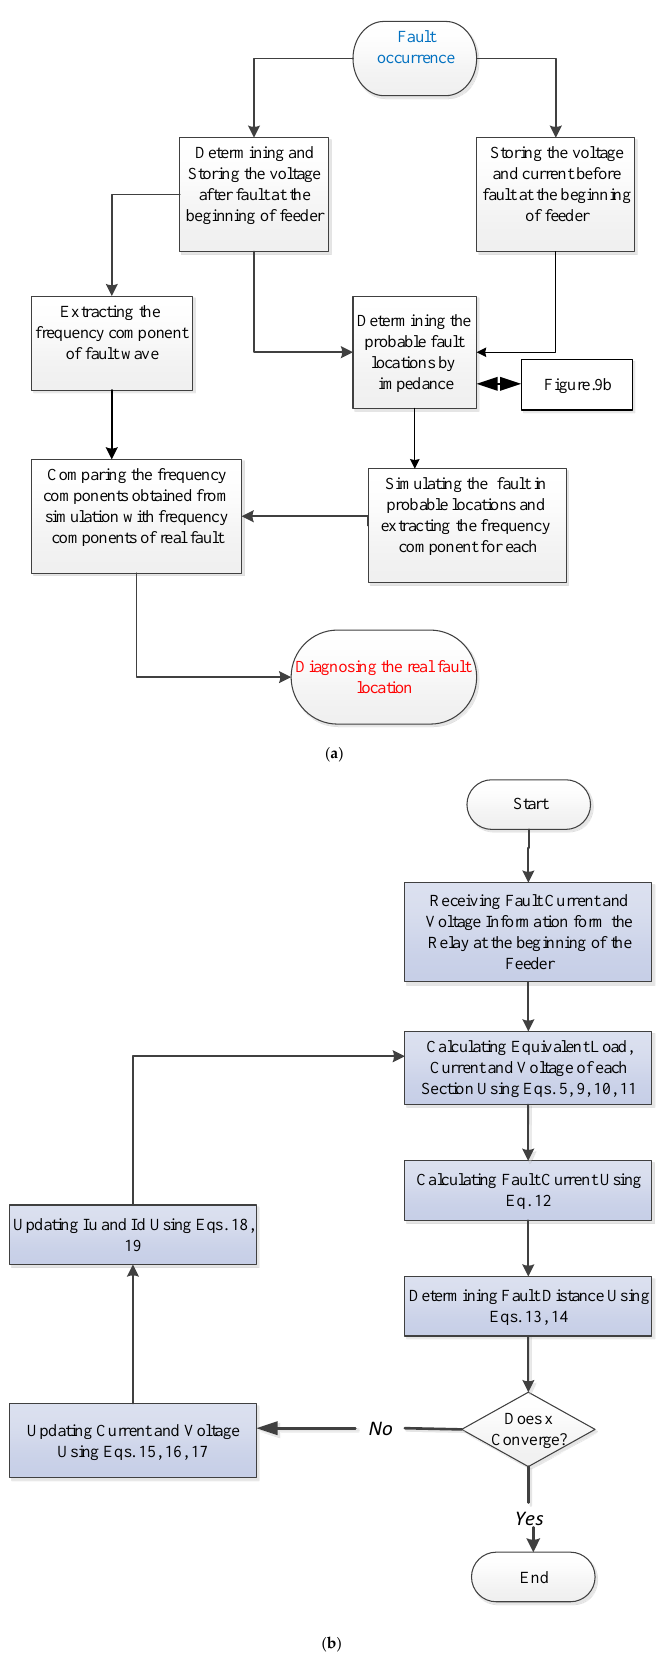
Figure 9. ( a ) Flowchart of the proposed method. ( b ) Flowchart of the proposed fault location